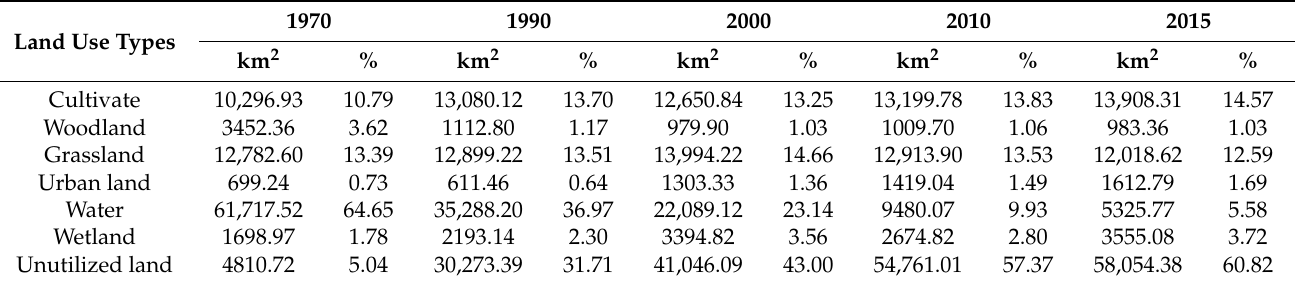
Table 4. Statistical areas and percentages of different land use types.